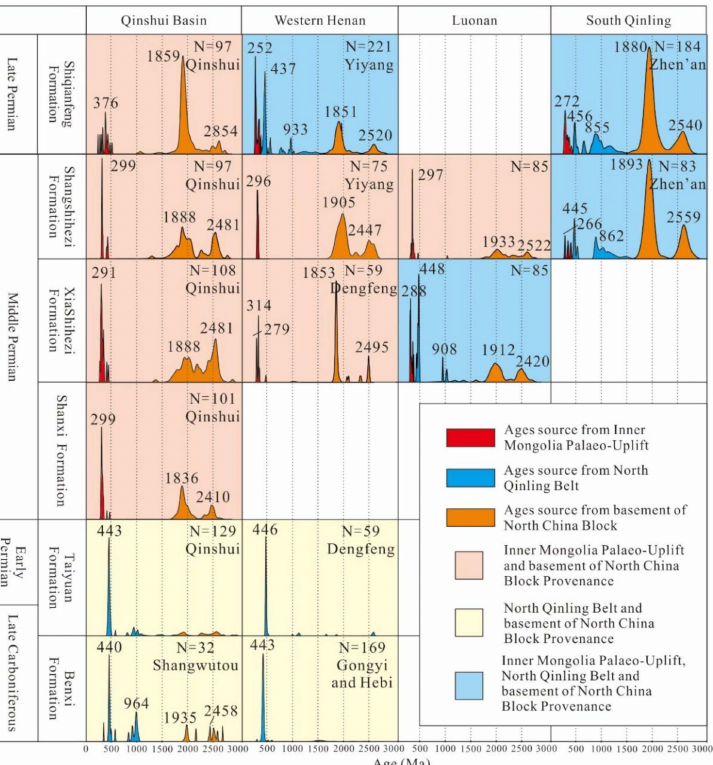
Figure 5. Comparison of detrital zircon U-Pb age spectrum obtained from south North China